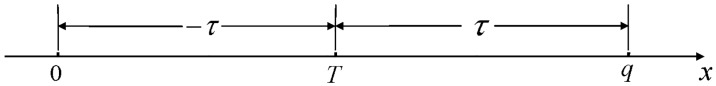
The SS-SRP contract faced by retailer.